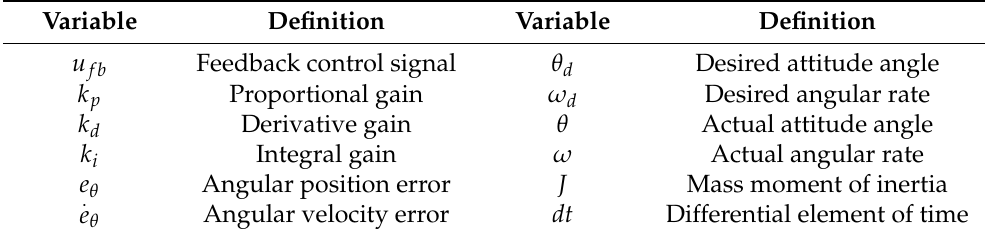
Table 2. Definitions of proximal variables for Section 2.2.